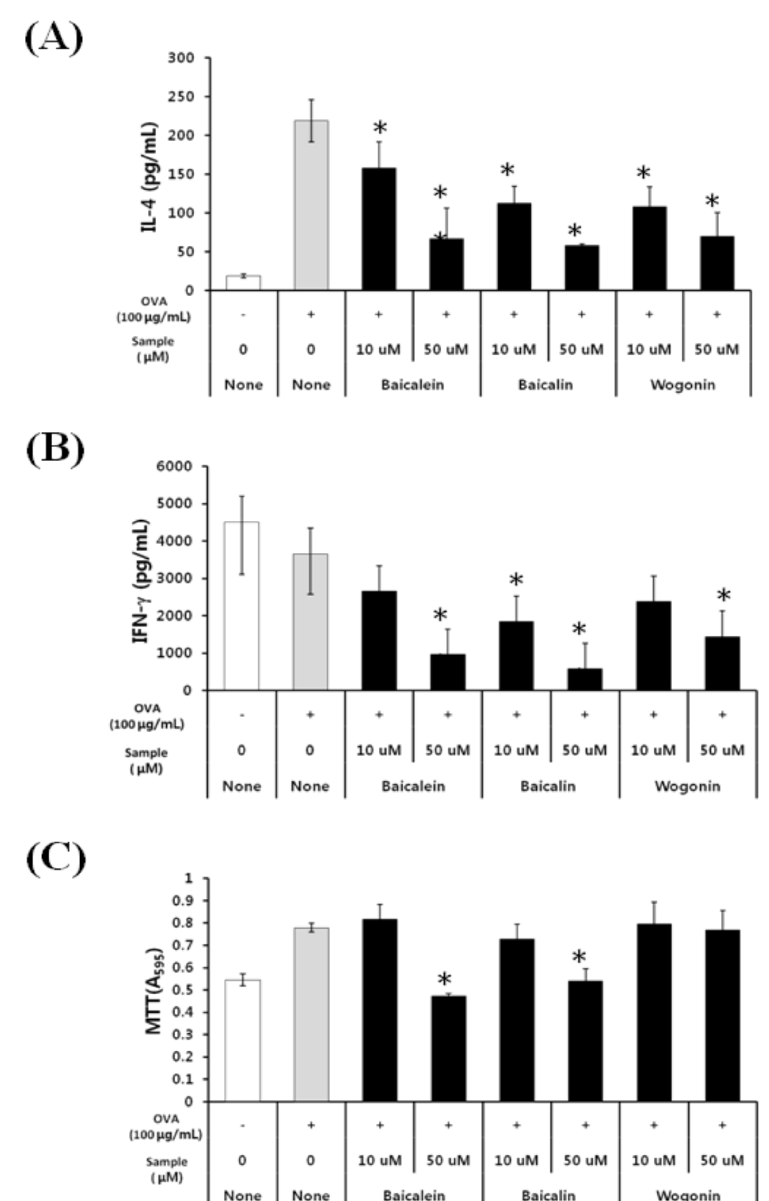
Figure 3. Effects of baicalein, baicalin, and wogonin on OVA-induced Th2 immune